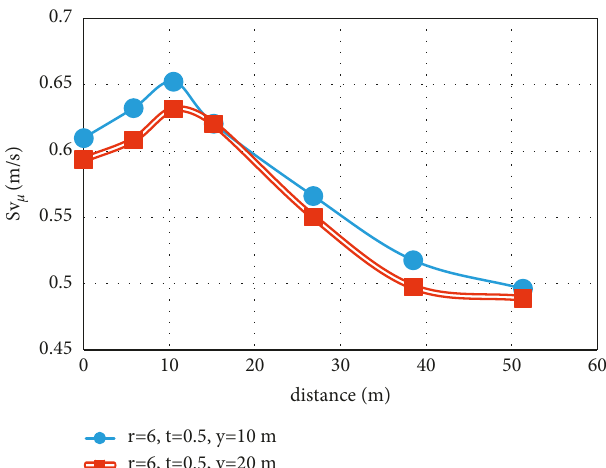
Figure 14: The effect of change in overburden depth on ground surface velocity for models 32 and 33 of Table 1.